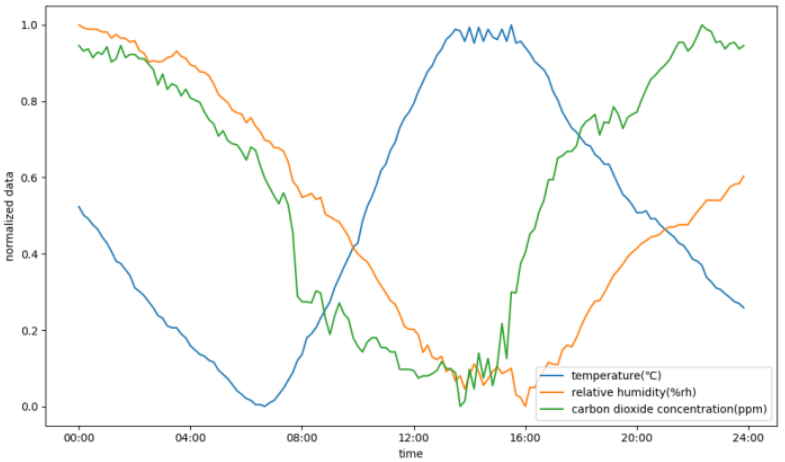
Figure 7. The rabbit house environmental variables within a day.